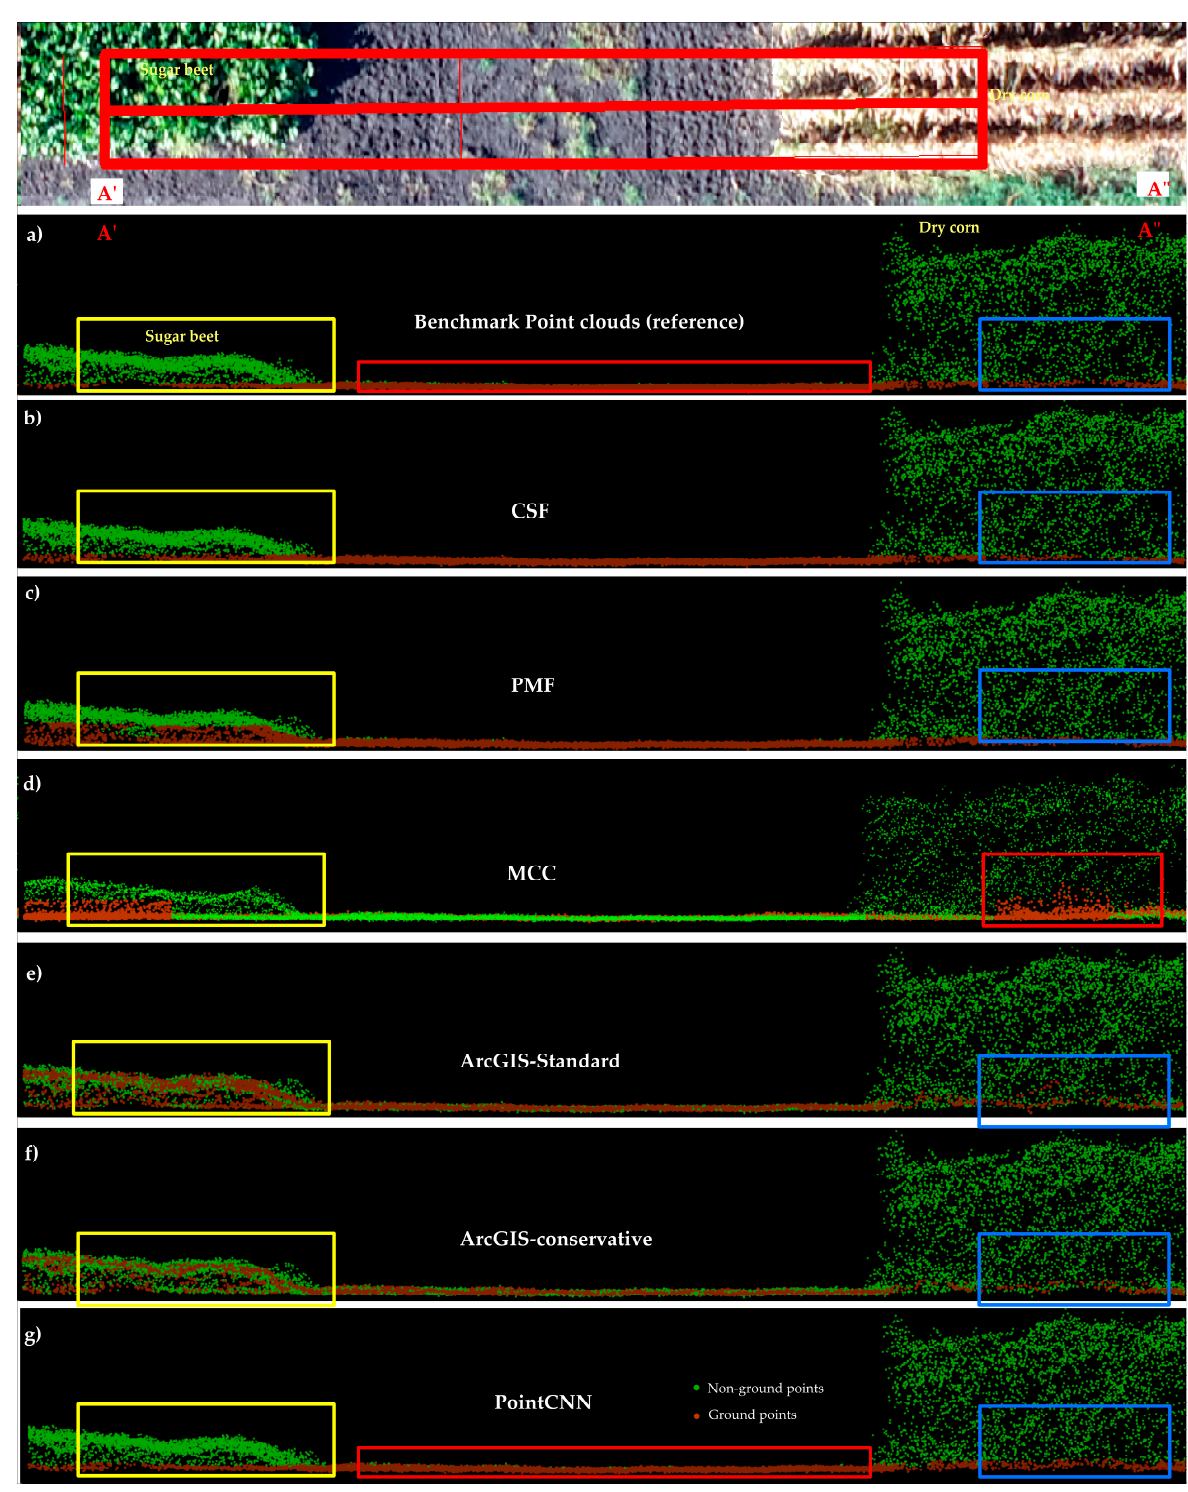
Figure 10. Visual evaluation (Site A) of ground classification algorithms and PointCNN using a 3D transect (A’A”) of point clouds: ( a ) Benchmark point clouds. Classification results for ground (brown) and non ‐ ground (green) points using ( b ) CSF, ( c ) PMF, ( d ) MCC, ( e ) ArcGIS standard, ( f ), ArcGIS conservative, and ( g ) PointCNN. Three ‐ dimensional transects ( a – g ) are of the same extent (horizontal) for visualization purposes with no vertical scale generated using ESRI ArcMap 10.8 LAS dataset profile view.